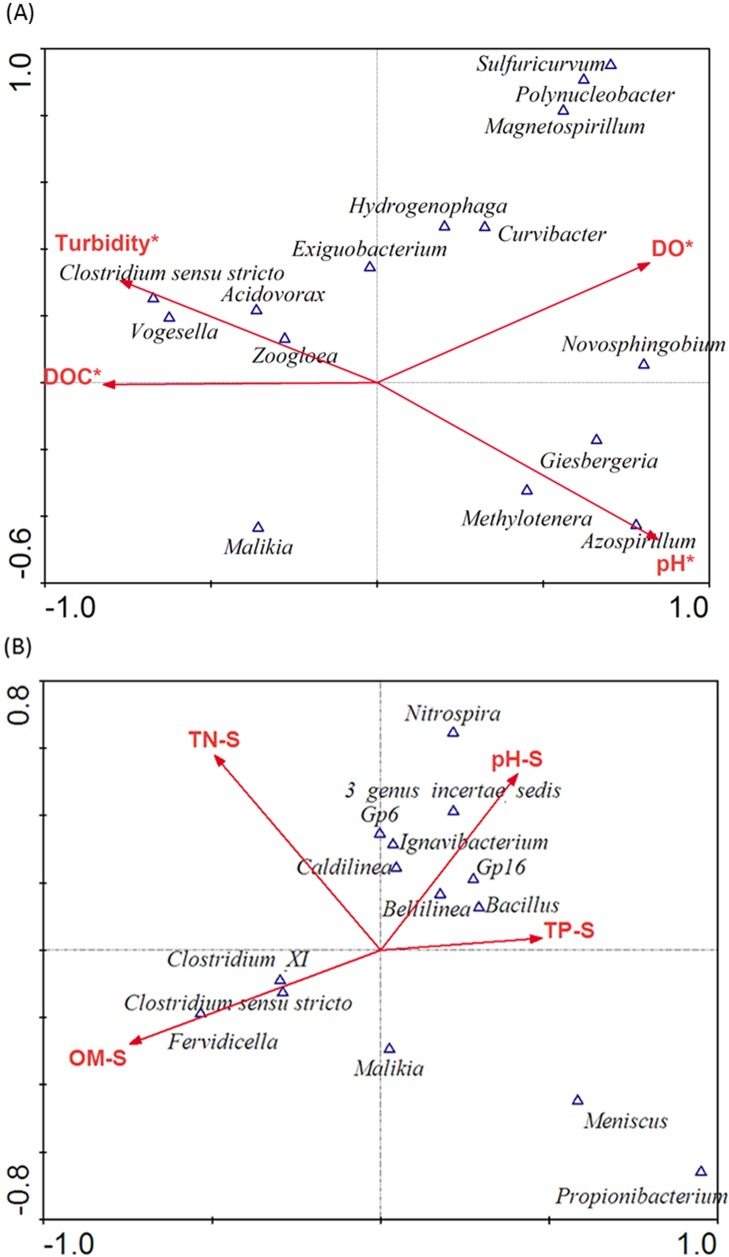
Ordination biplots of canonical correspondence analysis (CCA) of environmental variables and bacterial genera in (A) water and (B) sediments of the incubation systems. The relative abundances of the involved genera are > 1% and > 0.5% for water and sediment samples on average. DO, dissolved oxygen; DOC, dissolved organic carbon; ORP, oxidation reduction potential; TP, total phosphorus; TN, total nitrogen; OM, organic matter; -S, Environmental variables in the sediments. * P < 0.05, Monte Carlo permutation test.